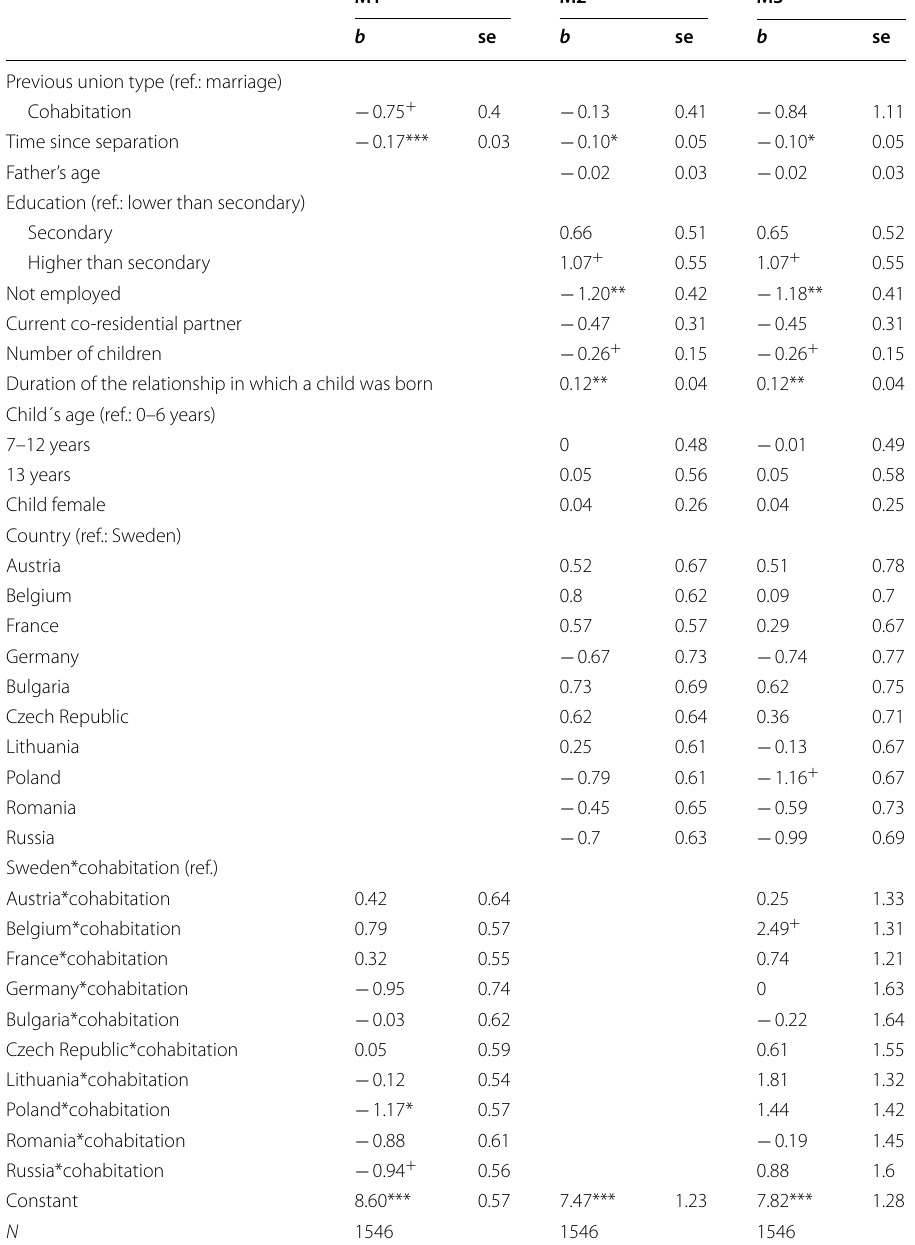
Table 8 Father’s satisfaction with the quality of relation with a child without multiple